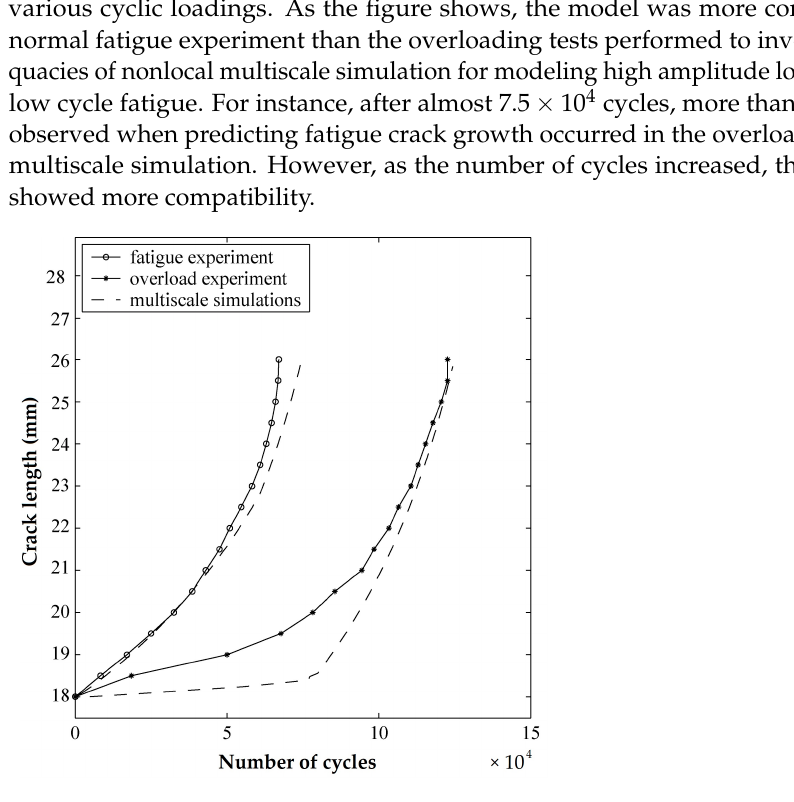
Figure 15. Comparison of multiscale simulations and experimental data [94].